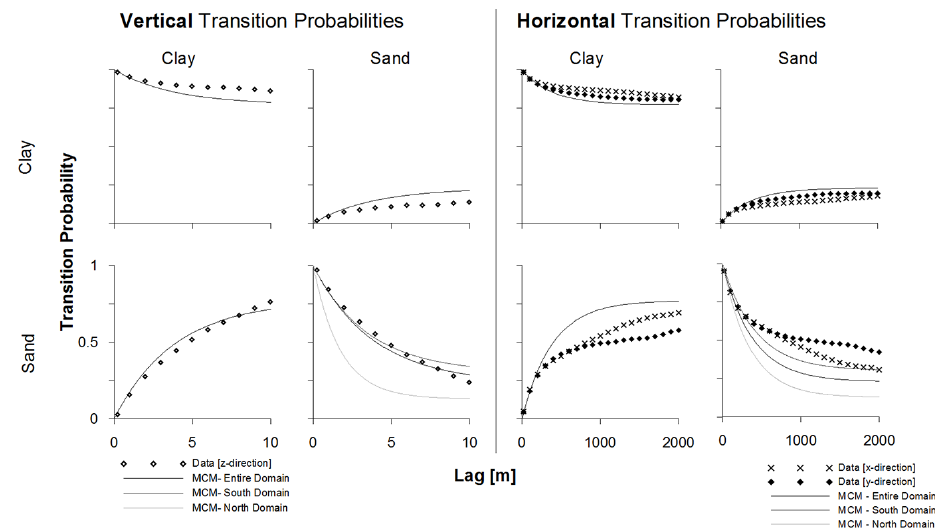
Figure 6. The computed transition probabilities in the vertical and horizontal direction and the fitted MCM: vertical 5m, horizontal 500m mean length of a sand lens and 23% sand proportion. Additionally the fitted MCM for the north and south subdomain are plotted for the vertical and horizontal sand–sand transitions: 2m, 400m and 13% (vertical) and 5m, 600m and 30%